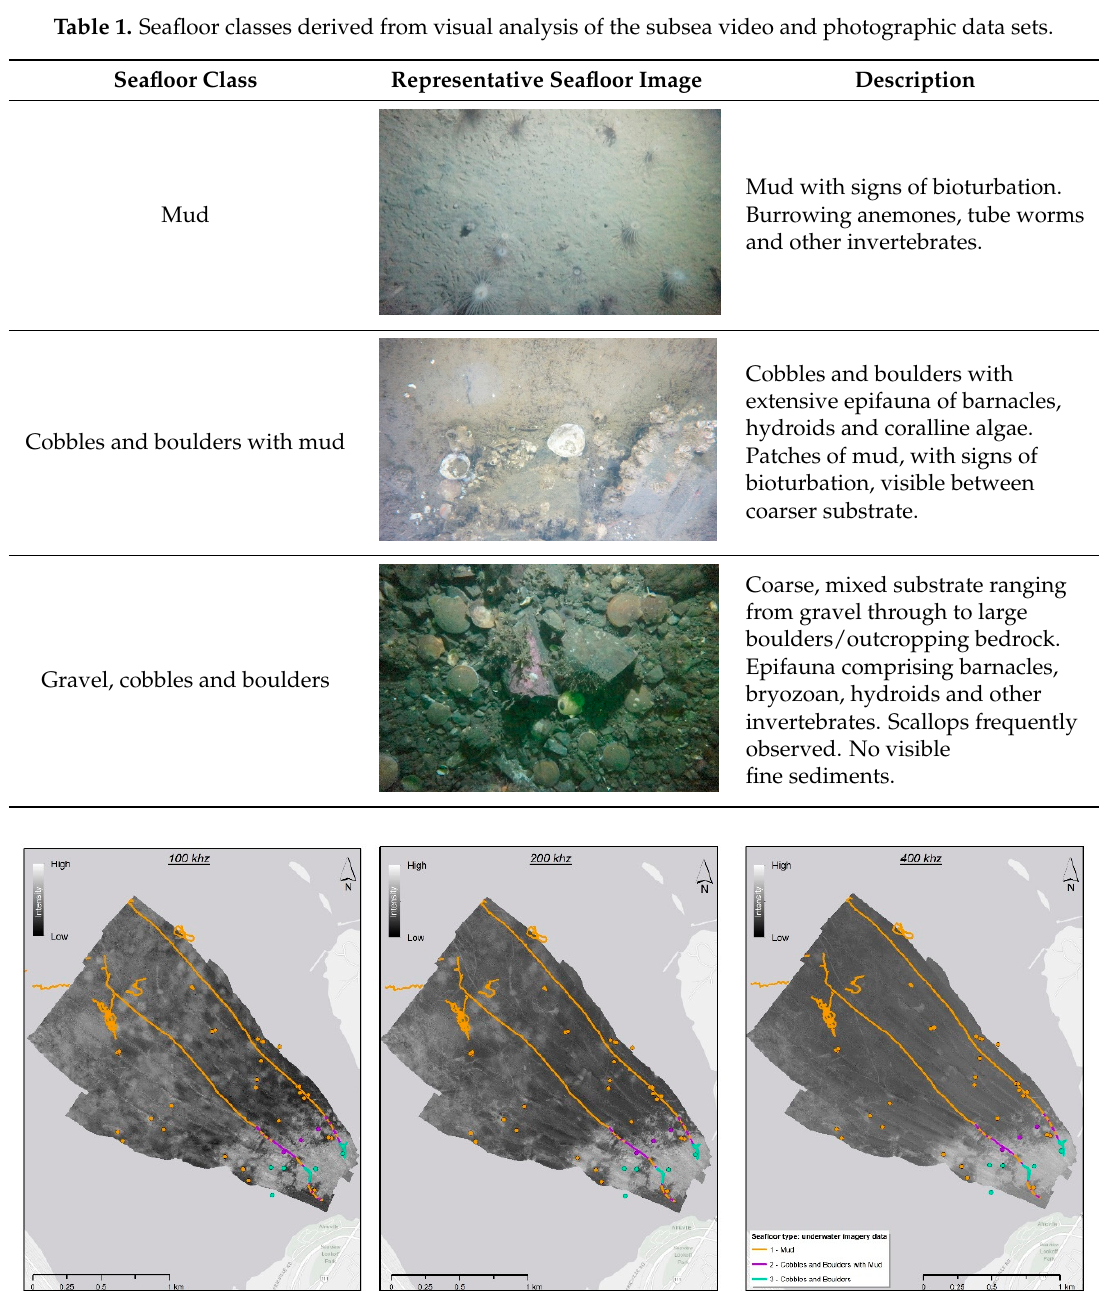
Figure 6. Classified video and photographic ground truthing data sets overlaid on a combined 2016 and 2017 100 kHz backscatter mosaic. Table 1. Seafloor classes derived from visual analysis of the subsea video and photographic data sets.